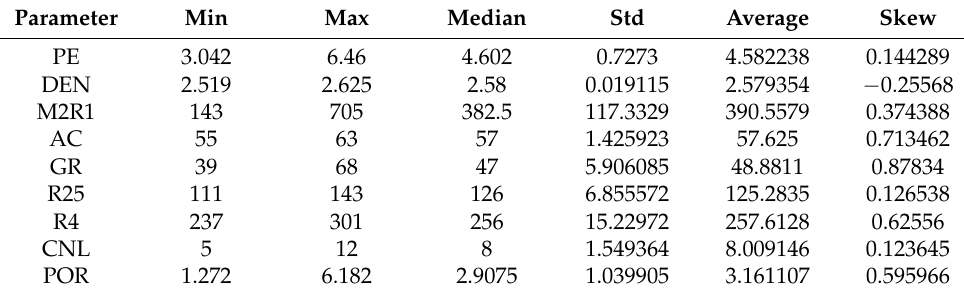
Table 2. Data statistics and interpretation.